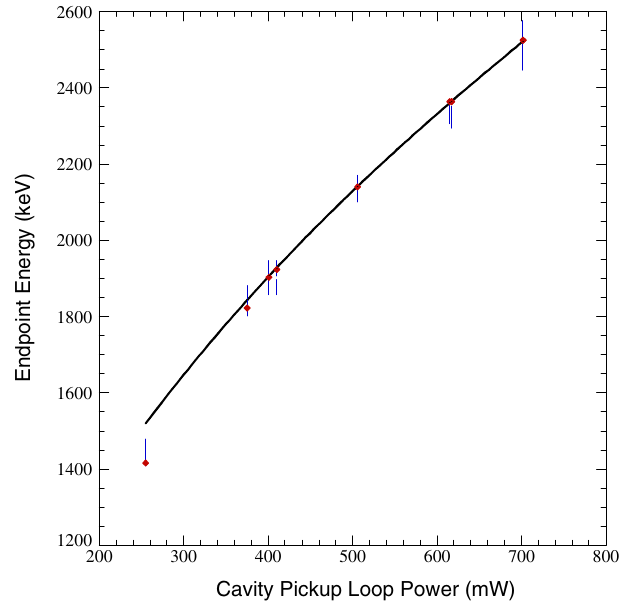
FIG. 8. End-point photon energy versus cavity power. The vertical bars are measured data (cid:4) 2 standard deviations, the red circles are PARMELA prediction, and the line is analytic